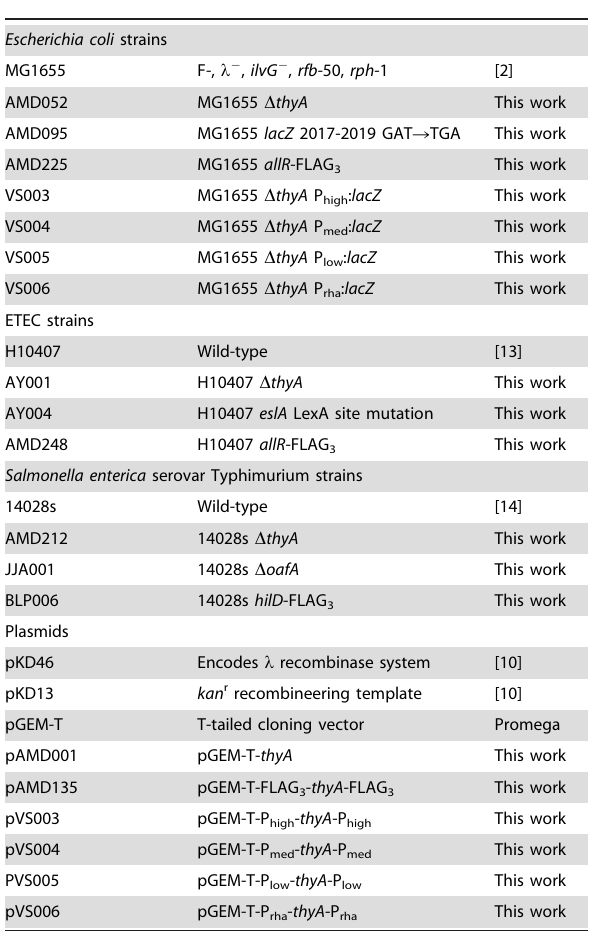
Table 1. List of strains and